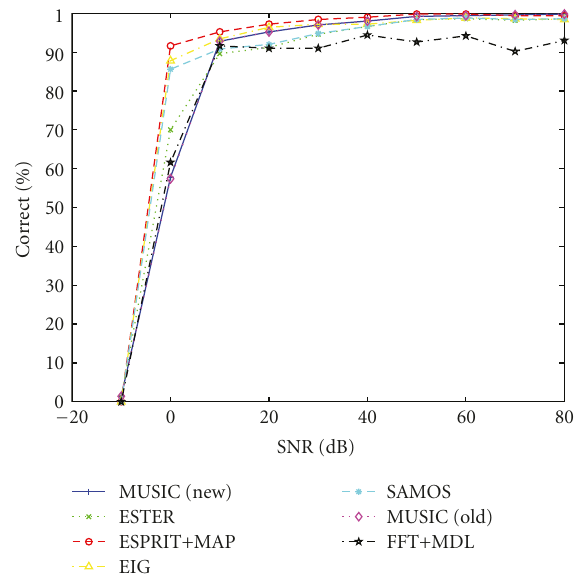
Figure 3: Percentage of correctly estimated model orders versus the SNR for N =